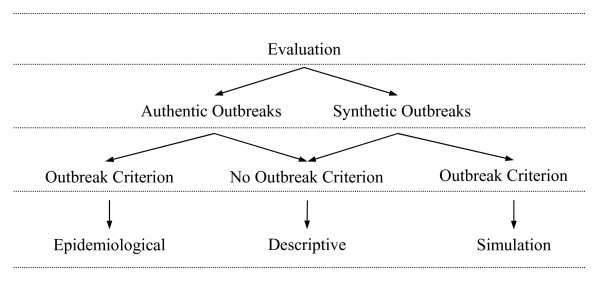
Framework for the classification of approaches used to evaluate outbreak detection methods for infectious disease surveillance.